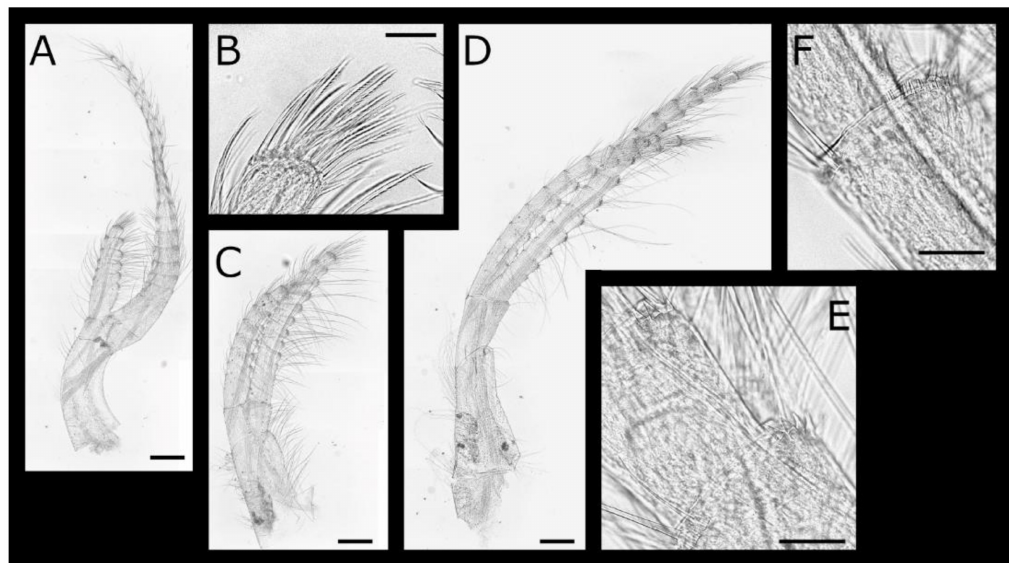
Figure 19. Pectinoacasta cancellorum (Hiro, 1931) cirri I–III (WAM C55340). ( A ) left cirrus I; ( B ) serrulate setae on cirrus I anterior ramus terminal segment; ( C ) cirrus II; ( D ) Cirrus III; E, erect spines on cirrus III anterior ramus; ( E ) ctenoid scales on cirrus III posterior ramus. Scale Bars: A, C–D = 200 µ m; B, E–F = 50 µ m.